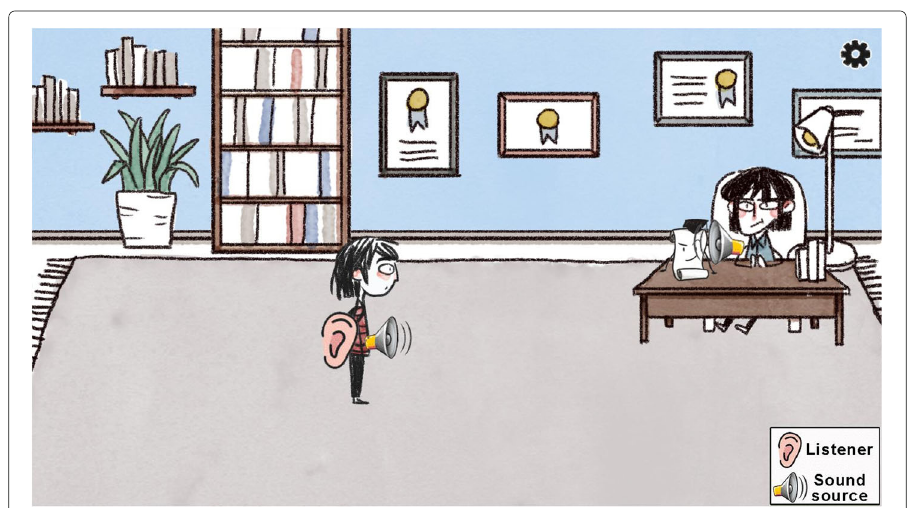
Fig. 1 Tutorial stage with indication of the listener’s position and the scenario sound sources